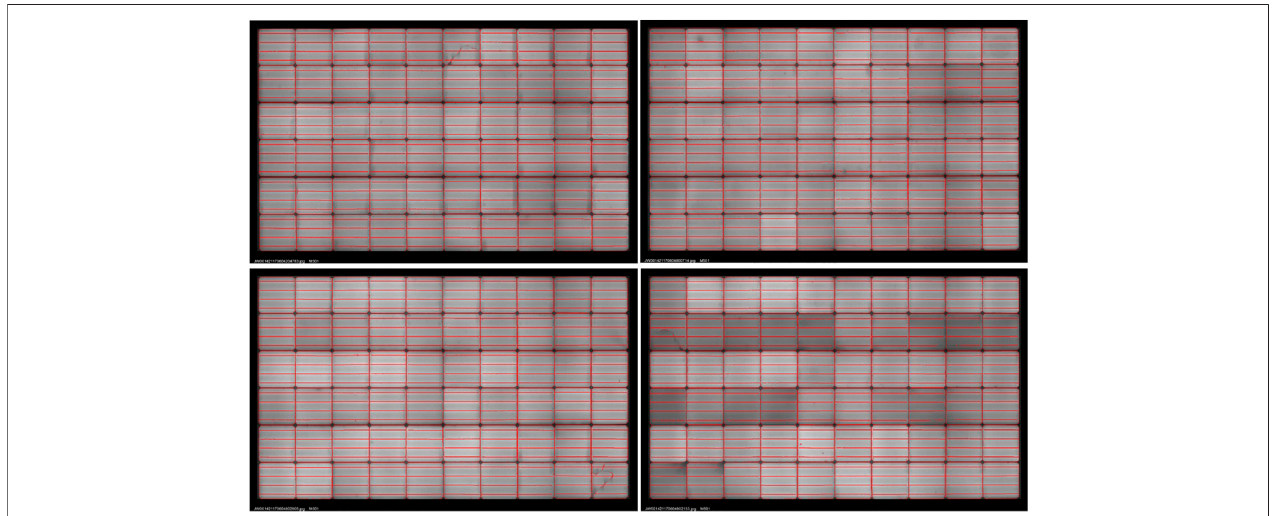
FIGURE 8 | The effect diagram obtained by using the Prewitt operator alone.